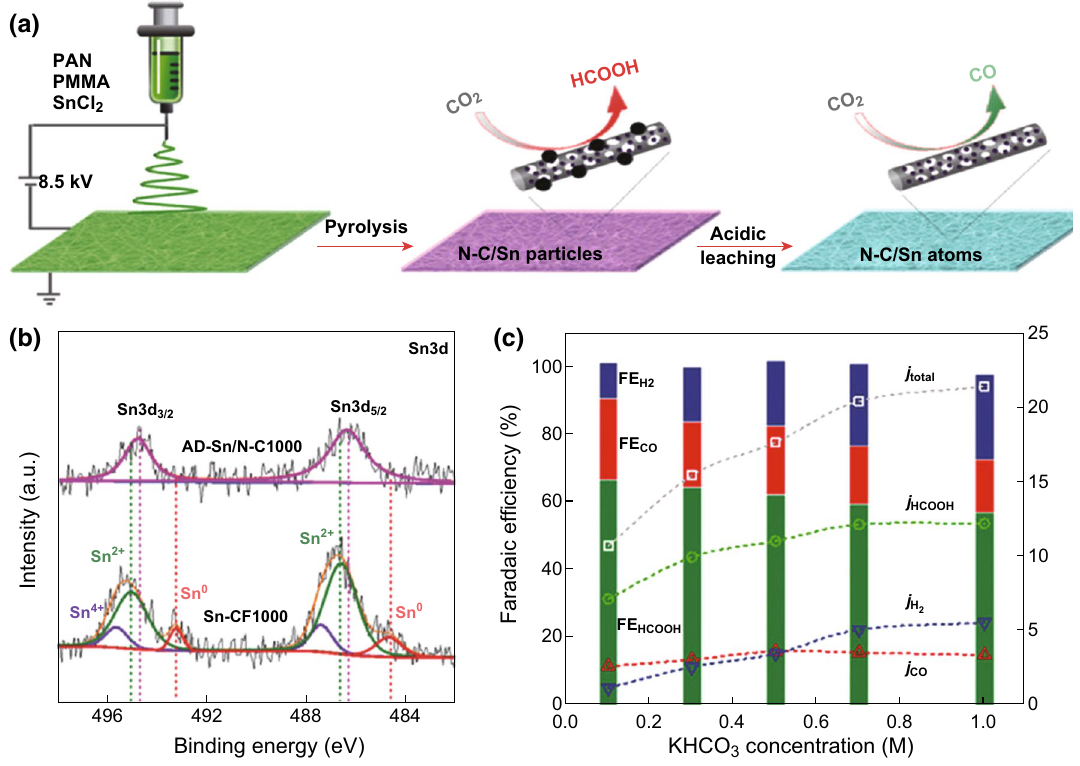
Fig. 3 a Schematic illustration of the fabrication process of Sn‑modified N‑doped carbon nanofiber electrocatalysts. b High‑resolution Sn3d XPS spectra for AD‑Sn/N‑C1000 and Sn‑CF1000. c FEs and partial current densities of three products on Sn‑CF1000 at − 0.8 V (vs. RHE) in CO 2 ‑saturated KHCO 3 solution with different concentrations. Reprinted with permission from Ref.